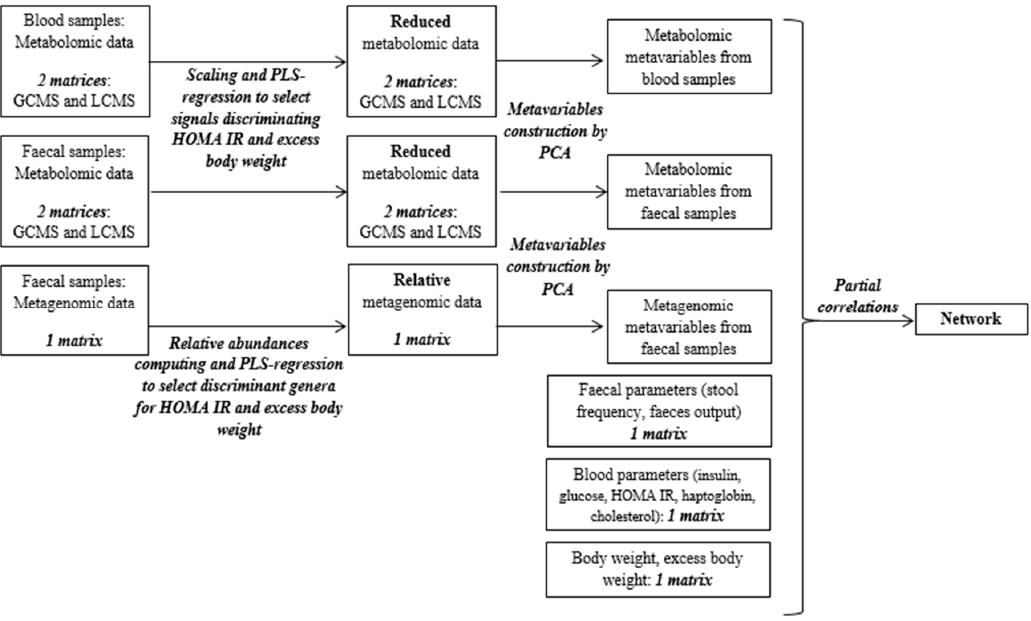
Figure 1. Workflow of the various statistical analyses performed to produce the correlation network.